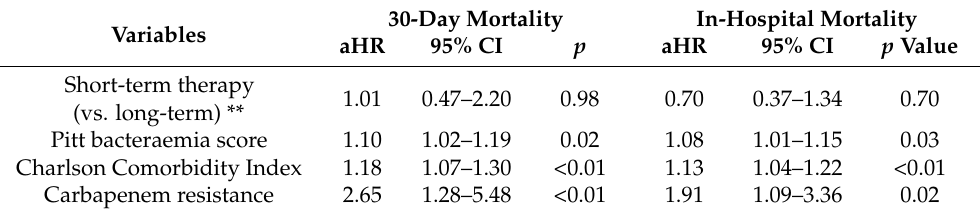
Table 2. Multivariate analysis for 30-day and in-hospital mortality in patients with